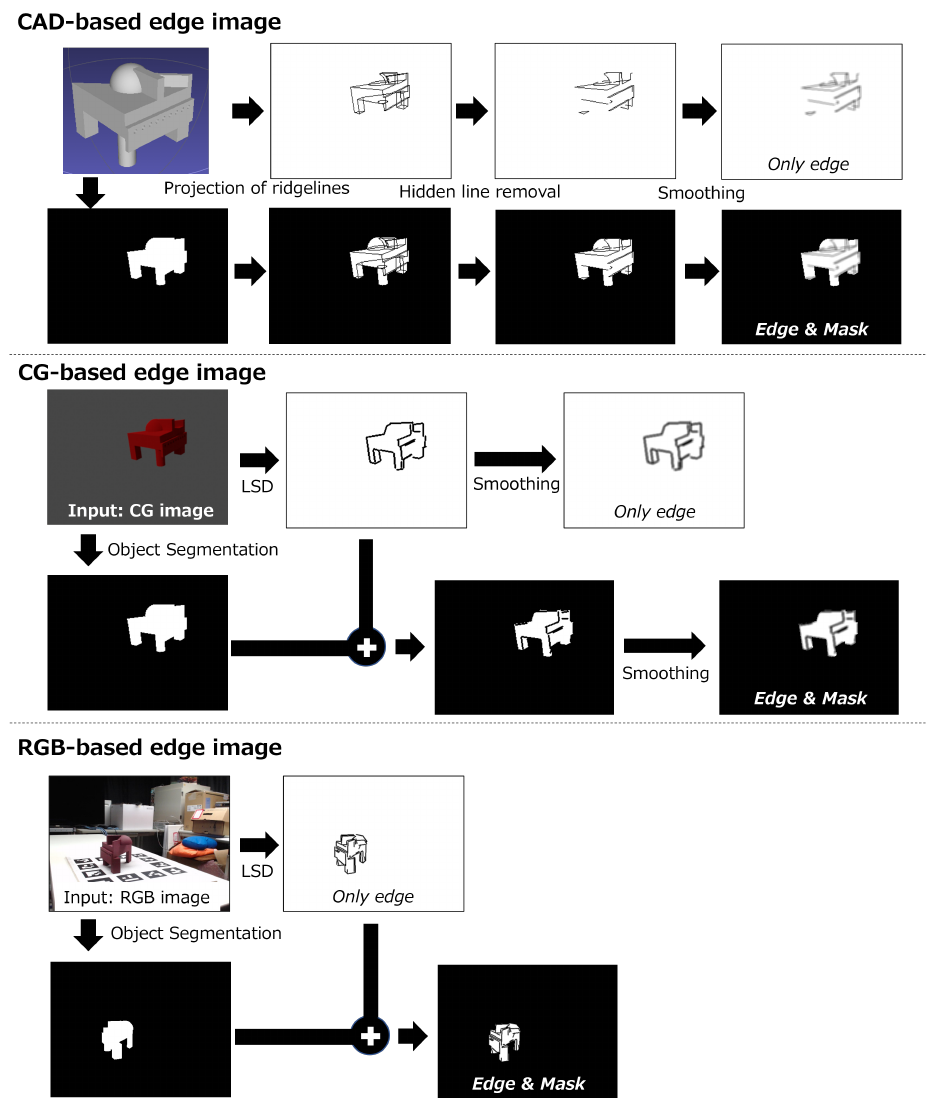
Figure 2. Process flow of edge image generation. Upper: CAD-based edge image. First, all ridgelines are projected. Then, hidden lines are removed. Finally, smoothing is adapted to each edge image. Middle: CG-based edge image. The 3D model is rendered by a renderer with certain environmental conditions. Then, line segments are detected and smoothing is adapted to each edge image. Lower: RGB-based edge image. The line segments are detected from RGB images. If a mask image is used, line segments are drawn onto the mask